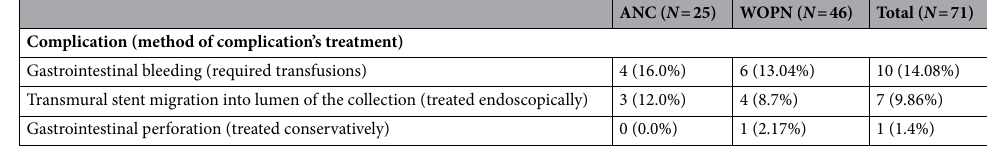
Table 4. Complications of endoscopic